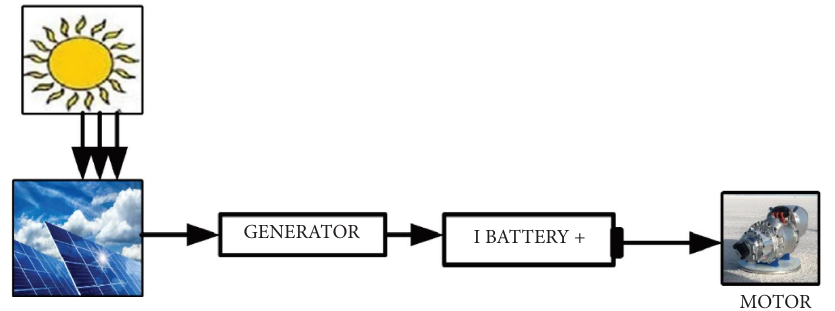
Figure 9: An ER-SES confguration block